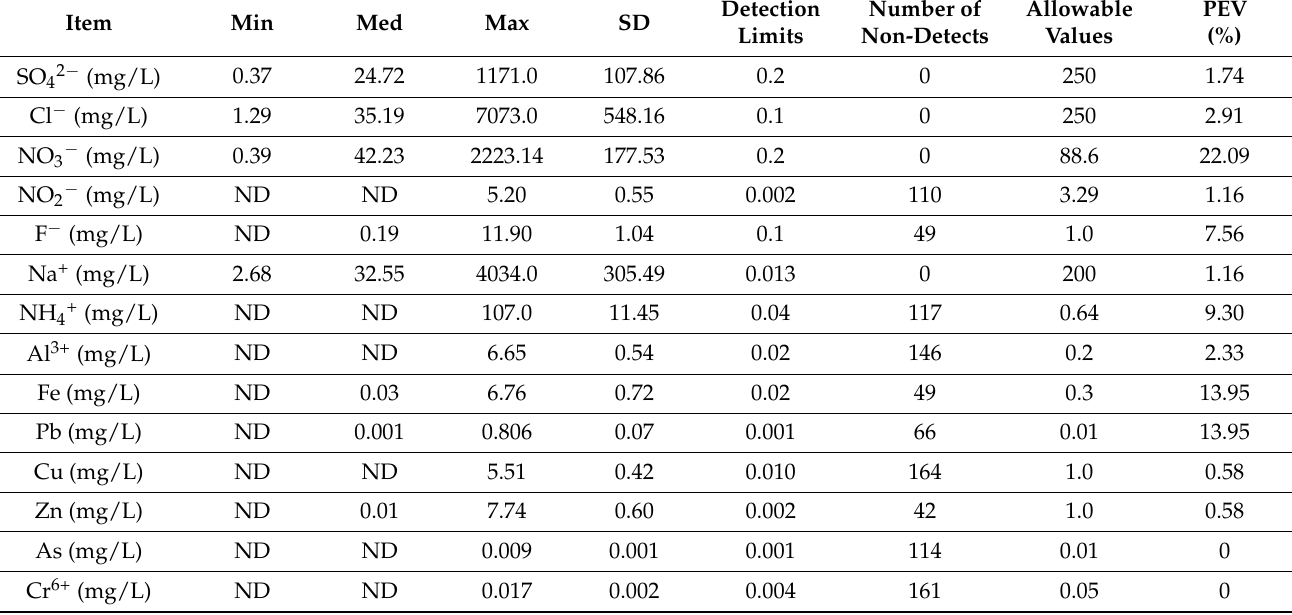
Table 1. Descriptive statistics of concentrations of groundwater